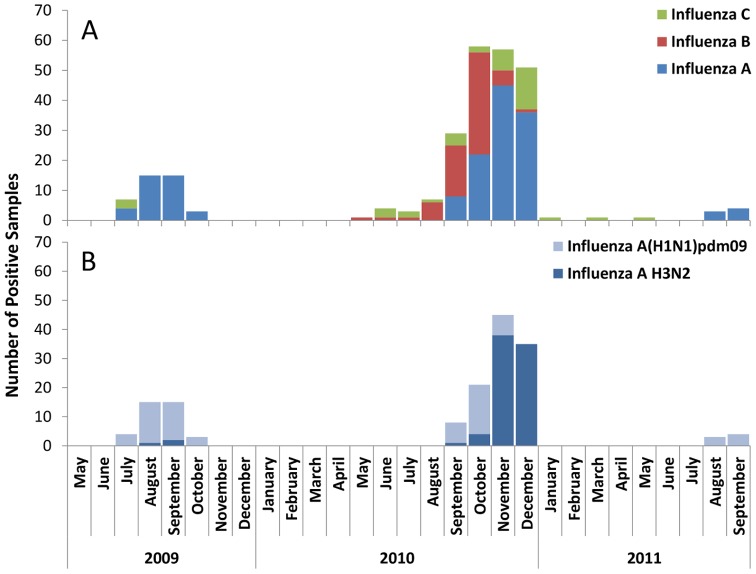
Seasonality of influenza-associated ARI.